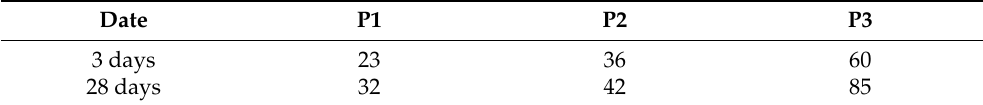
Figure 6. Load deflection curve of ECC prepared with different types of fly ash: ( a ) 3 days load deflection curve; ( b ) 28 days load deflection curve. Table 3. Bending toughness of ECC prepared with different types of fly ash kJ/m 3